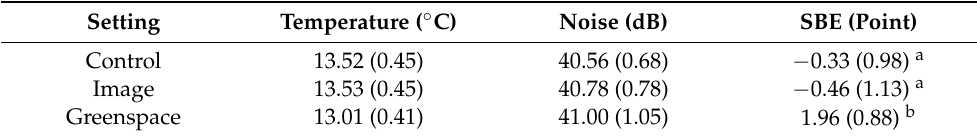
Table 2. Environmental parameters and scenic beauty assessment.